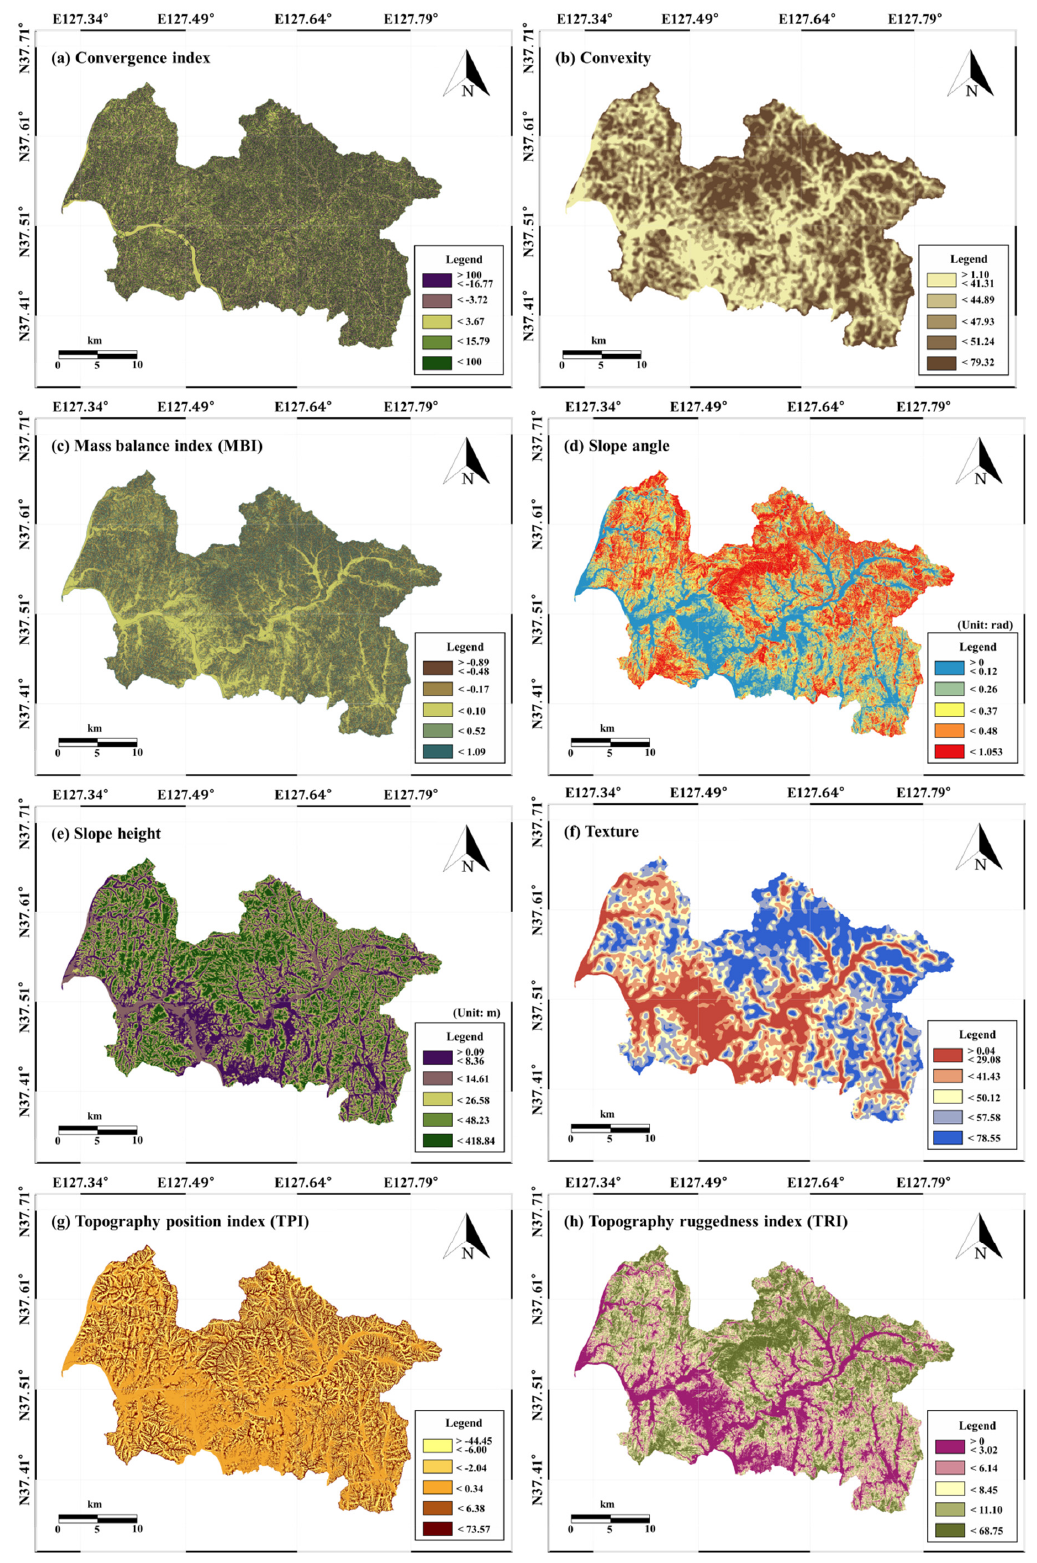
Figure 3. Groundwater conditioning factors I: ( a ) Convergence Index, ( b ) Convexity, ( c ) Mass balance index (MBI), ( d ) Slope angle, ( e ) Slope height, ( f ) Texture, ( g ) Topography position index (TPI) and ( h ) Topography ruggedness index